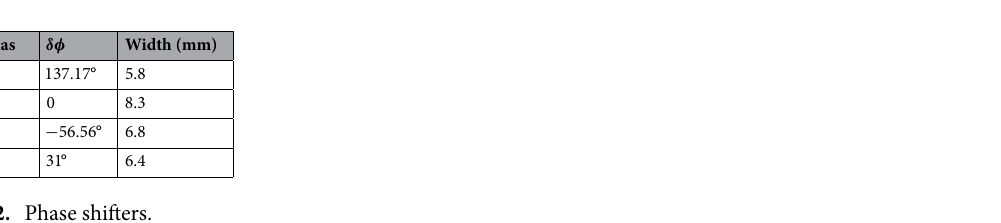
Table 2. Phase shifters.